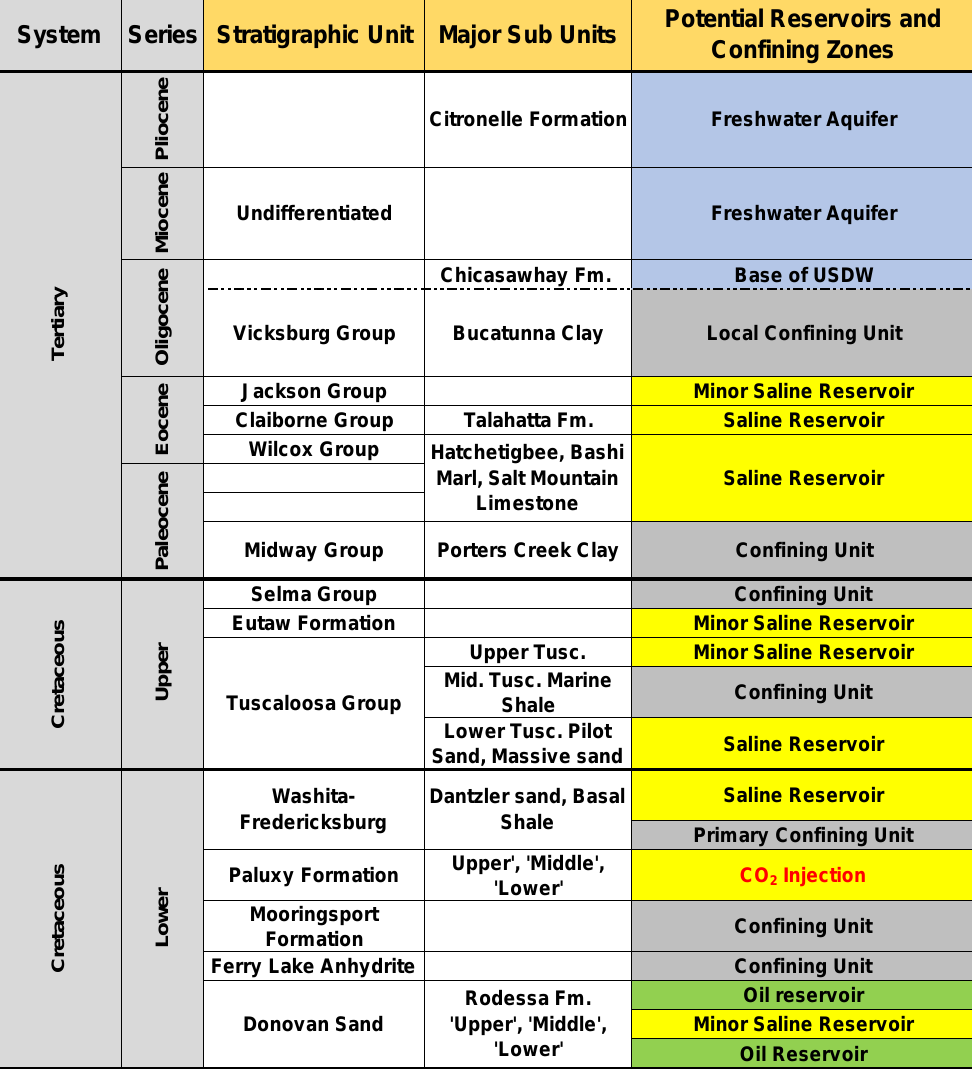
Figure 2. Stratigraphic chart of the Anthropogenic Test Site. Several major regional confining horizons, including the basal Washita Fredericksburg interval shale, the Marine Tuscaloosa shale and the Selma Group Chalk restrict vertical CO 2 migration.